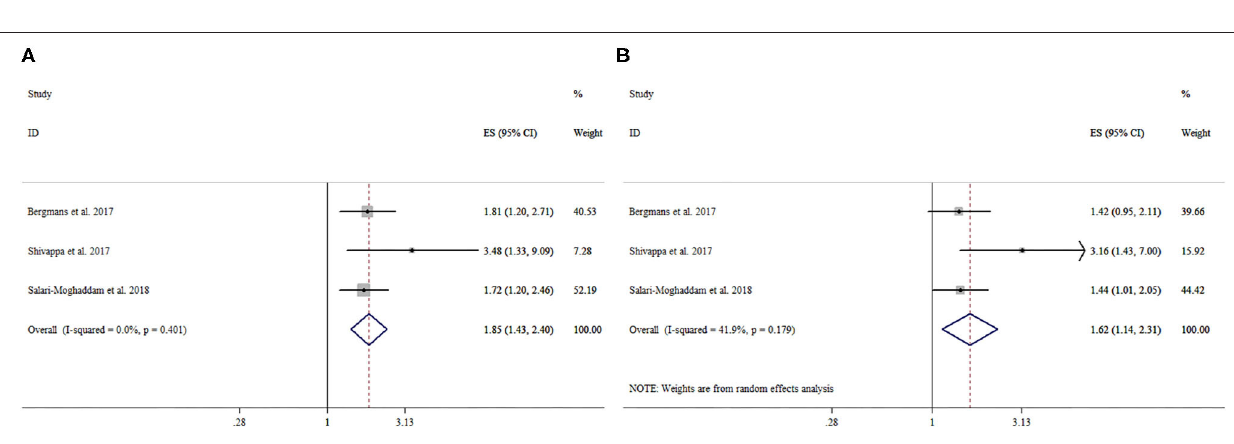
FIGURE 4 | Forest plot of the pooled effect estimates of distress. (A) The highest Dietary Inflammatory Index (DII) category compared with the lowest category. (B) The second highest DII category compared with the lowest